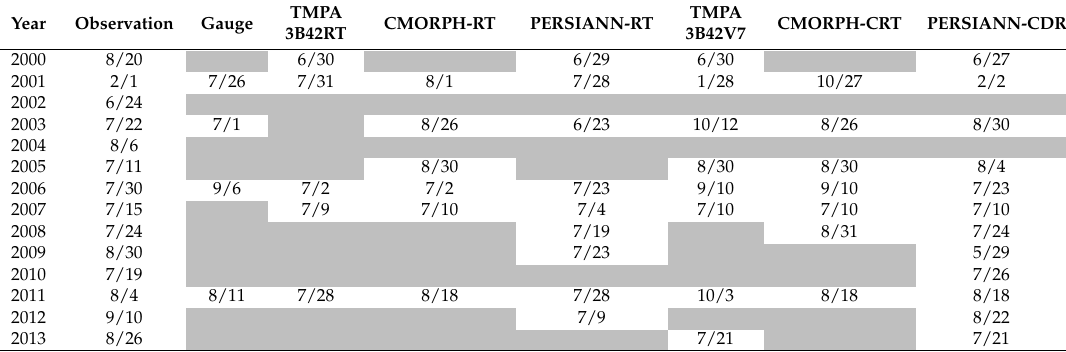
Table 7. Occurrence date of annual maximum 1-day streamflow (Q × 1 d) simulated by rain gauge observations and six SPPs for the period of 2000–2013. Gray boxes indicate the date of Q × 1 d simulated by each precipitation product is consistent with the date detected by gauge